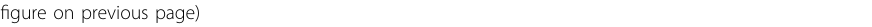
Fig. 4 Generalization of Recurrent-MZ to non-uniformly spaced input images. a Recurrent-MZ was trained on C. elegans samples with equidistant inputs ( M = 3, Δ z = 6 μ m), and blindly tested on both uniformly sampled and non-uniformly sampled input images of new samples. b The PSNR values of the output images of Recurrent-MZ with uniformly spaced and non-uniformly spaced input images, as well as the output images of 3D U-Net with non-uniformly spaced input images are all calculated with respect to the ground truth, corresponding image. Blue: Outputs of Recurrent-MZ ( M = 3) for uniformly spaced inputs, Red: Outputs of Recurrent-MZ ( M = 3) for non-uniformly spaced inputs, Gray: Outputs of 3D U-Net for non-uniformly spaced inputs (lower PSNR values are omitted). Dashed lines indicate the axial positions of the input 2D images. c In fl uence of hyperparameter Δ z on Recurrent-MZ inference performance. We report the PSNR values of the output images of Recurrent-MZ ( M = 3) models that were trained using different Δ z = 4, 6, and 8 μ m, but blindly tested on new samples imaged with Δ z = 6 μ m. The input images are captured at z = 3, 6, and 9 μ m. d The boxplot of the PSNR values of the 3 networks (trained using Δ z = 4, 6 and 8 μ